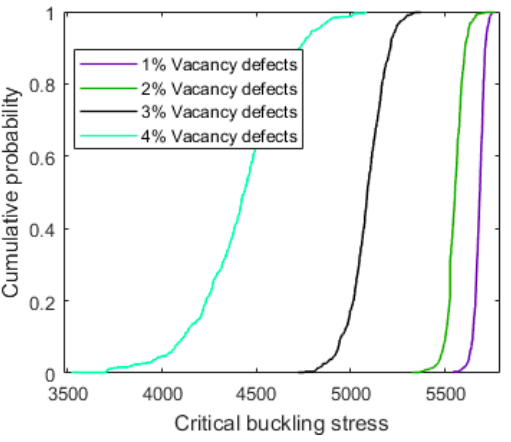
Figure 5. Comparison of the cumulative probability for graphene sheets with different amounts of vacancy defects.